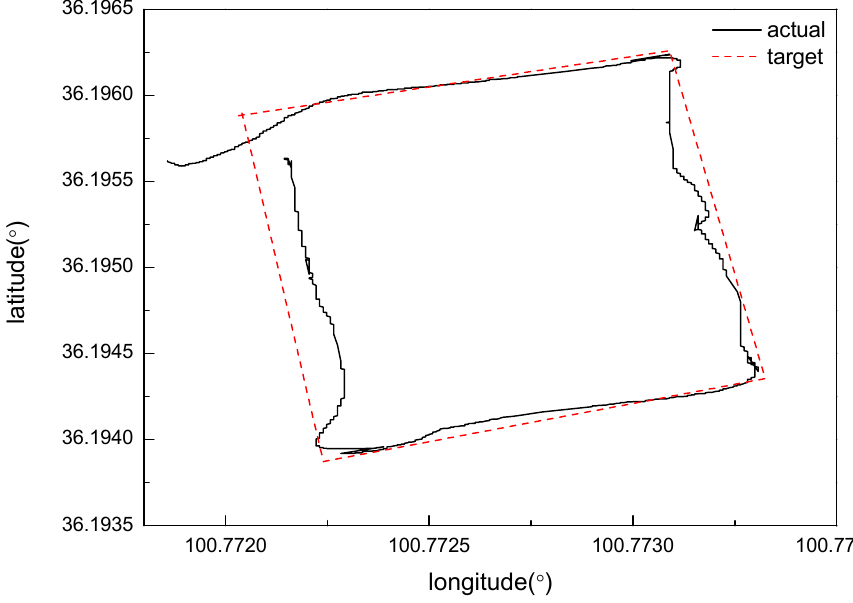
Figure 20. Experimental result of path tracking.